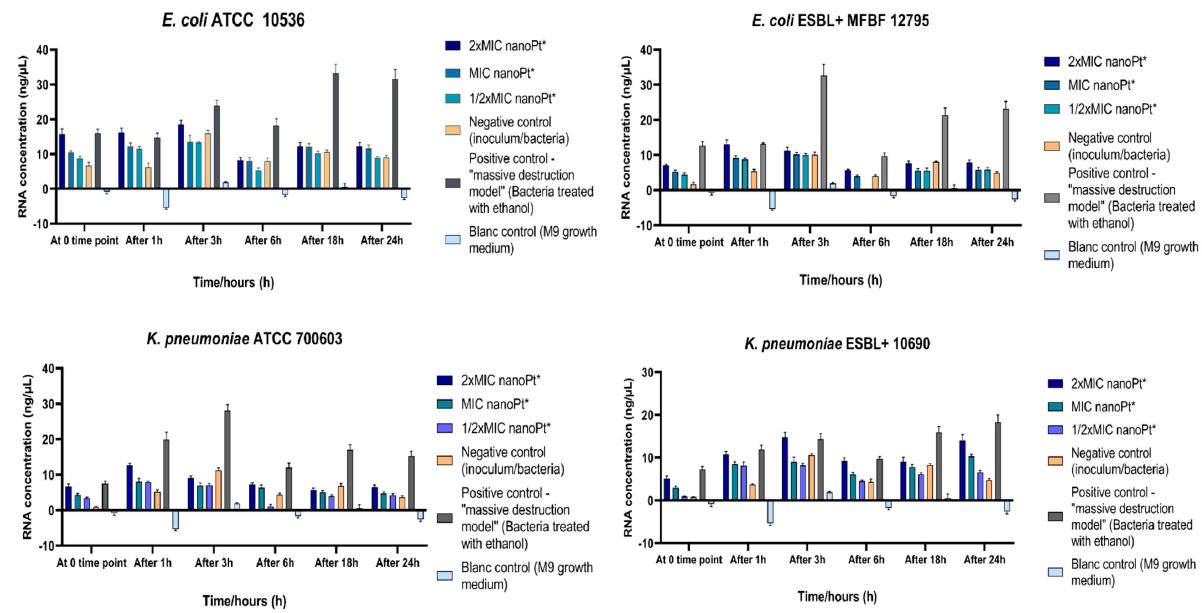
Figure 6. Interrelations of extracellular DNA/RNA concentrations over time for all tested bacterial strains. nanoPt*—platinum nanoparticles. strains. nanoPt*—platinum